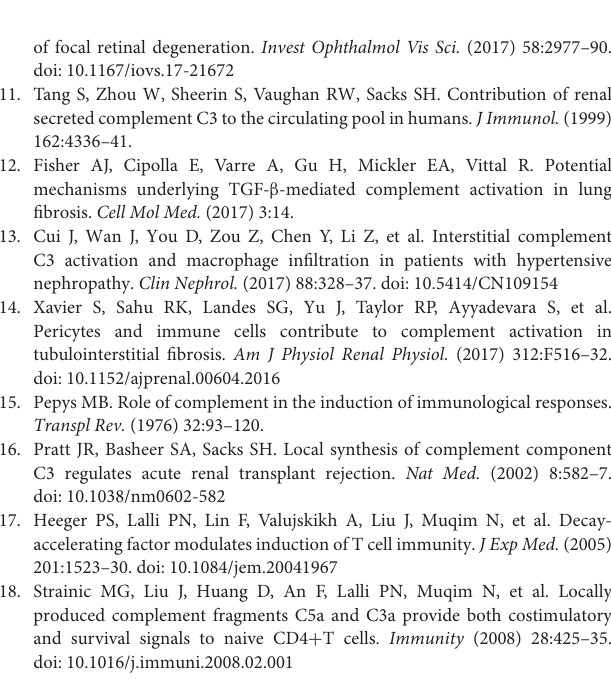
liposomes and control liposomes. On days 7 and 14, mice were sacrificed, and the left kidneys were collected. The expression levels of C3 and fibrotic markers ( α -SMA, PDGFR- β , and Collagen I) were detected by real-time PCR (A) and Western blot analyses (B) , respectively. (C) The histogram shows the relative intensity for each marker normalized to GAPDH. n = 6 per group. The error bars represent the SEM. ∗ P < 0.05; ∗∗ P < 0.01; ∗∗∗ P < 0.001. Supplement Figure S3 | C3 deficiency reduces C3 expression and fibrosis during UUO. UUO mice were subcutaneously injected with control peptide and Cp40. On days 7 and 14, mice were sacrificed, and the left kidneys were collected. (A) Masson’s trichrome staining indicates collagen deposition. IHC staining showing α -SMA and C3 protein expression in these groups ( n = 6); original magnification, × 400. Scale bar, 50 µ m. Quantitative analysis of interstitial fibrosis (B) , a-SMA (C) and C3 (D) positive cells were shown as mean ± SEM. (E) The expression levels of C3, TGF- β 1, and fibrotic markers ( α -SMA, PDGFR- β , and Collagen I) were detected by Western blot. (F) The histogram shows the relative intensity for each marker normalized to GAPDH. n = 6 per group. The error bars represent the SEM. ∗ P < 0.05; ∗∗ P < 0.01; ∗∗∗ P < 0.001. Supplement Figure S4 | CD11b + F4/80 + macrophages are not the main producer of IL-17A in kidney of UUO mice. Flow cytometric analysis of kidney cell suspensions from the obstructed kidneys injected with or without Cp40 at (A) 7 days and (C) 14 days post UUO; n = 6. Cells were stimulated in vitro with PMA/Ionomycin/Golgi-plug for 4h. Specific staining of cell markers (anti-F4/80, anti-CD11b) and intracellular staining for IL-17A were performed. The F4/80 + cells were gated. Among them, the CD11b + IL-17 + cells were further gated for the analysis. Plots are gated for live CD11b + F4/80 + IL-17A + macrophages; numbers indicate events in the quadrants as percentages of all gated events. (B,D) Quantifications of CD11b + F4/80 + IL-17A + cells as percentages of all kidney cells isolated from the C3 blockade UUO mice and UUO mice. The error bars represent the SEM. ∗∗∗ P < 0.001. The data were pooled from three independent experiments. Supplement Figure S5 | T cells were knocked down endogenous C3aR by using three small-interfering RNAs (siRNAs). (A) The expression levels of C3aR was detected by Western blot. (B) The histogram shows the relative intensity for each marker normalized to Actin. n = 3 per group. The error bars represent the SEM. ∗∗∗ P <